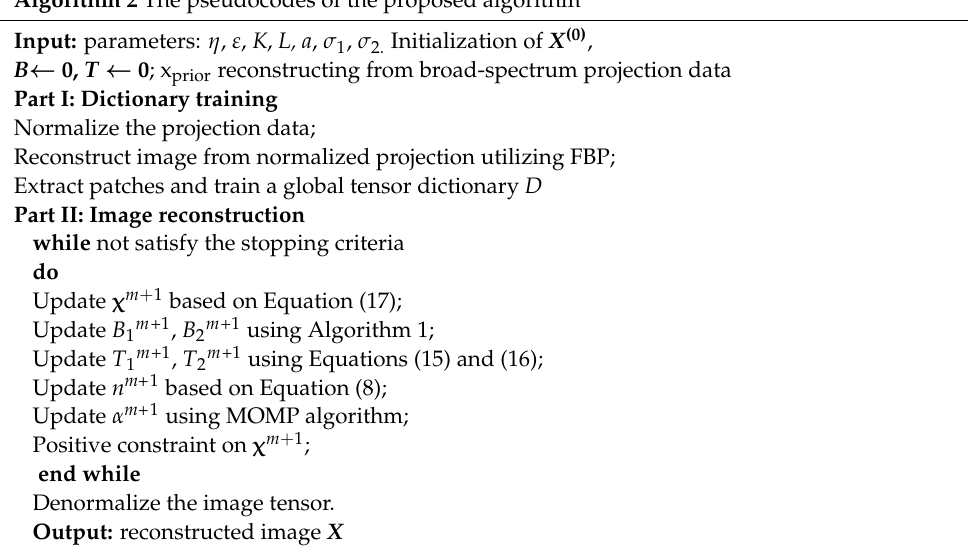
Algorithm 2 The pseudocodes of the proposed